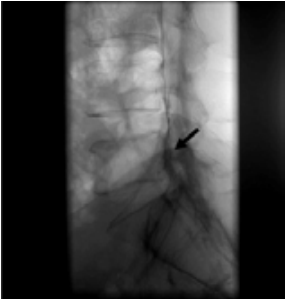
FIGURE 2 - After lysis of epidural